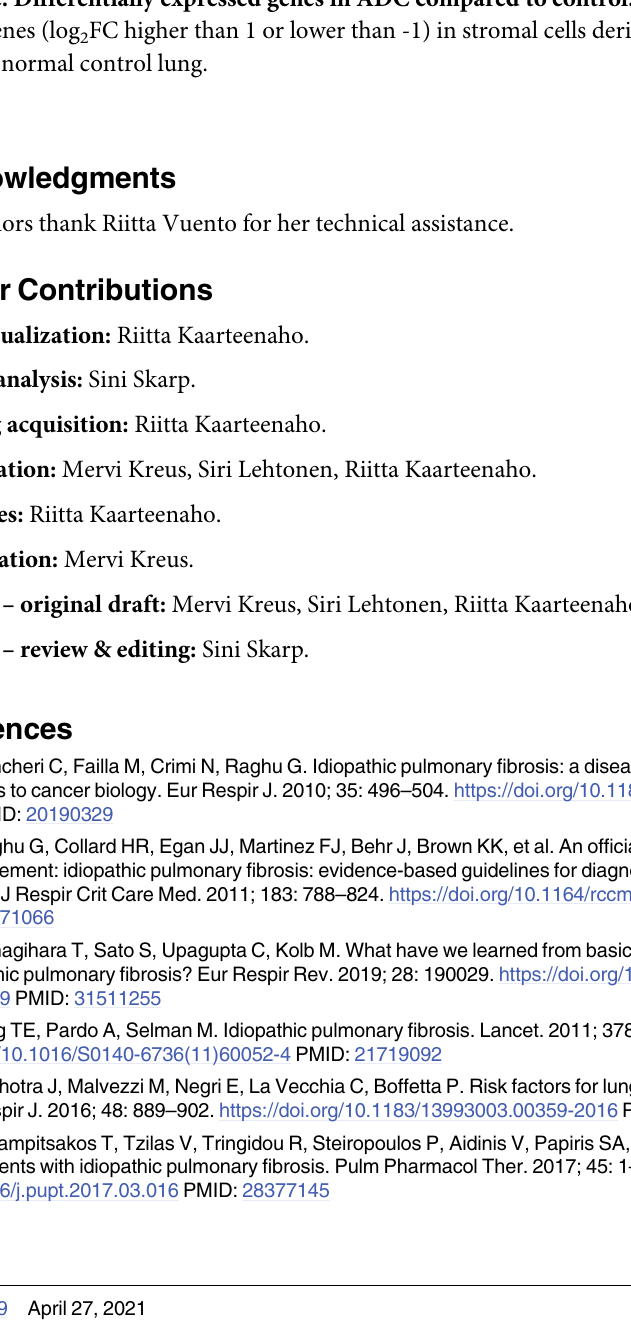
S6 Table. Differentially expressed genes in ADC compared to control. All up- or down-reg- ulated genes (log FC higher than 1 or lower than -1) in stromal cells derived from ADC com- 2 pared to normal control